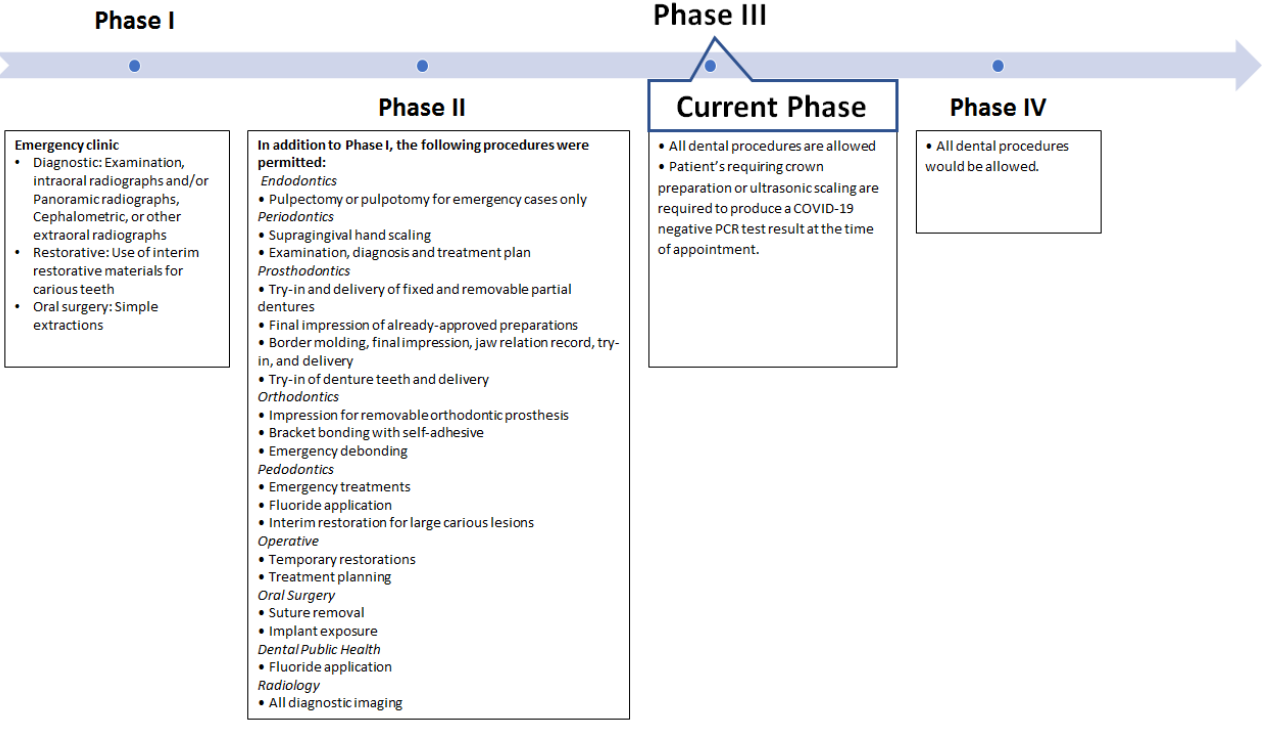
Figure 1. Dental clinic re-opening phases and the clinical procedures permitted in each phase.